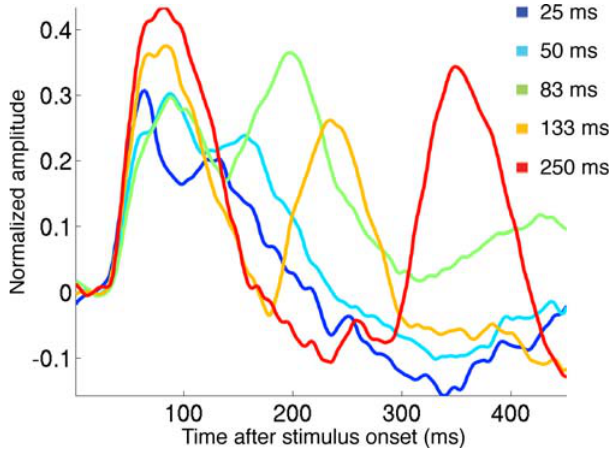
Figure 4. Mean relative population membrane potential. The D V(t) mean over all animals. The means were calculated from the relative means from each animal (1/5 S mean D V(t)rel, animal). The amplitude of the ON responses and OFF responses were significantly smaller and shorter for the 25 ms and 50 ms durations (p , 0.01), compared to the other durations. The other differences in amplitudes were not significant. Note the reduction of the D V(t) amplitude at durations 133 ms and shorter, the truncation of the 25 ms and 50 ms ON responses, the delayed OFF responses and the negativity of D V(t) for the 250 ms duration in between the ON and OFF responses. The standard errors are shown in Fig. 6.